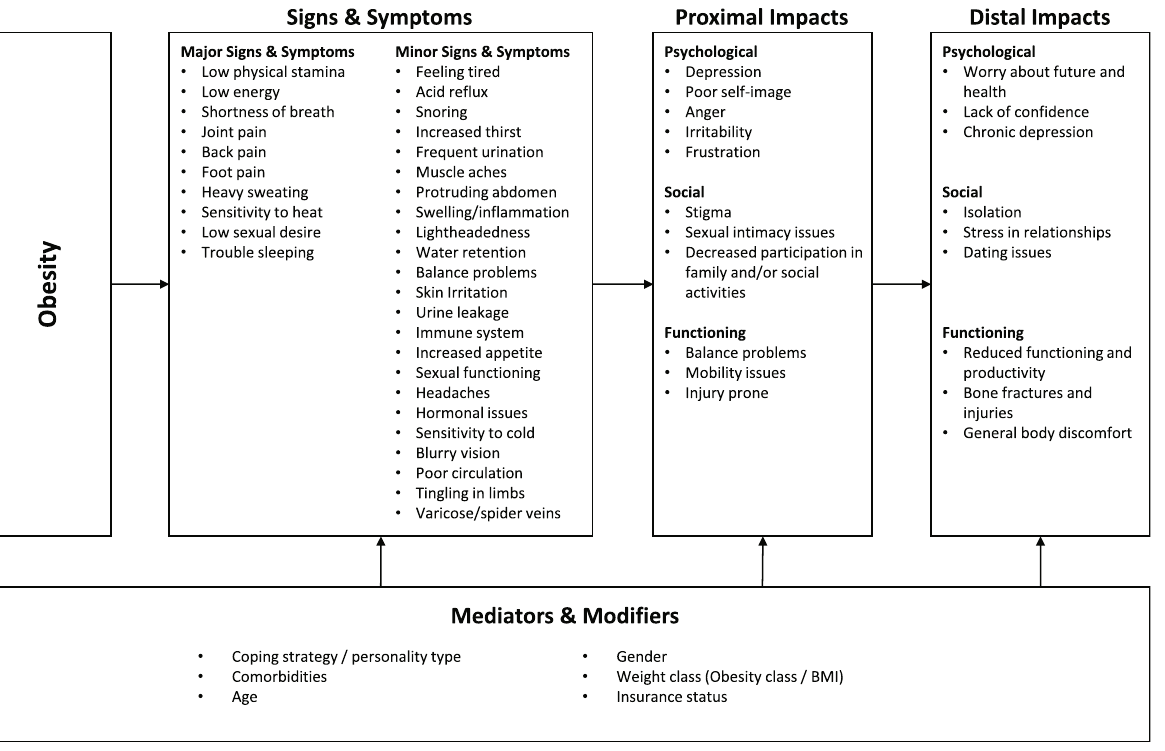
Fig. 1 Theoretical Model of the Weight-Related Sign and Symptom